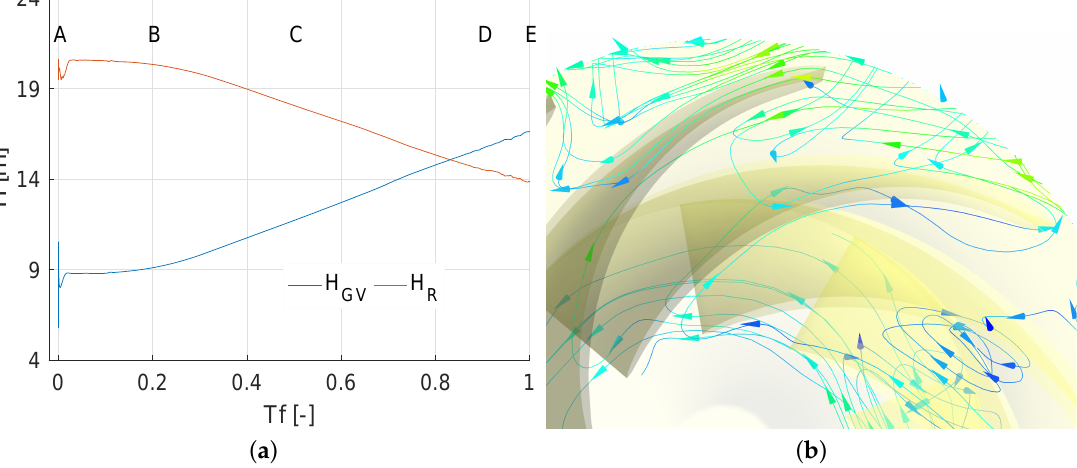
Figure 23. ( a ) Heads of the guide vane and the runner versus time factor; and ( b ) blocked runner